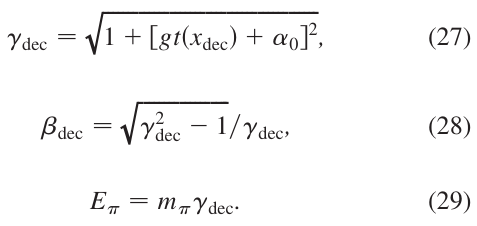
, (cid:1) and (cid:1)